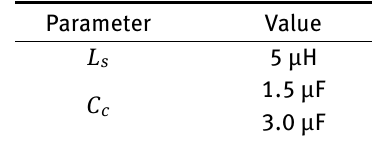
Table 4: Parameters to study the effect of absorption capacitance Parameter